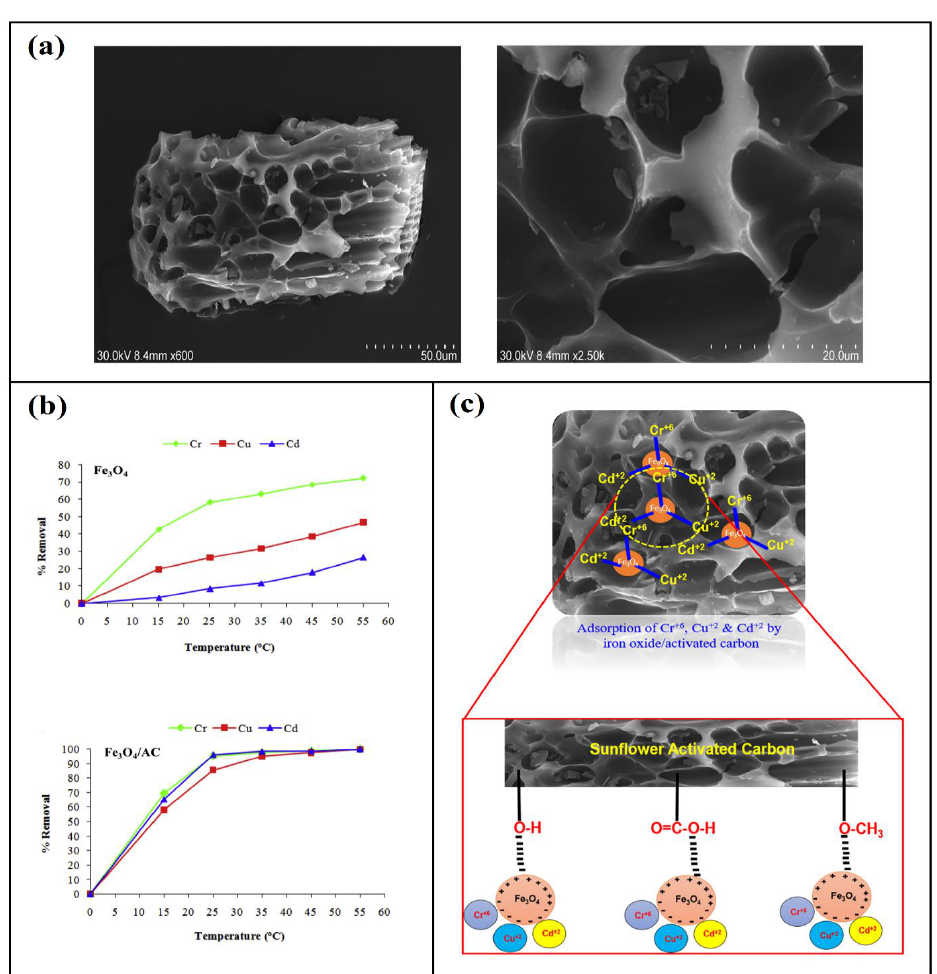
Figure 4. Illustration of sunflower-head-waste-based nano-activated carbon; ( a ) scanning electron microscope images at different magnifications, ( b ) effect of temperature on the adsorption, and ( c ) schematic drawing of adsorption process of heavy metals. Reprinted with permission from Ref. [79], 2018, Elsevier.